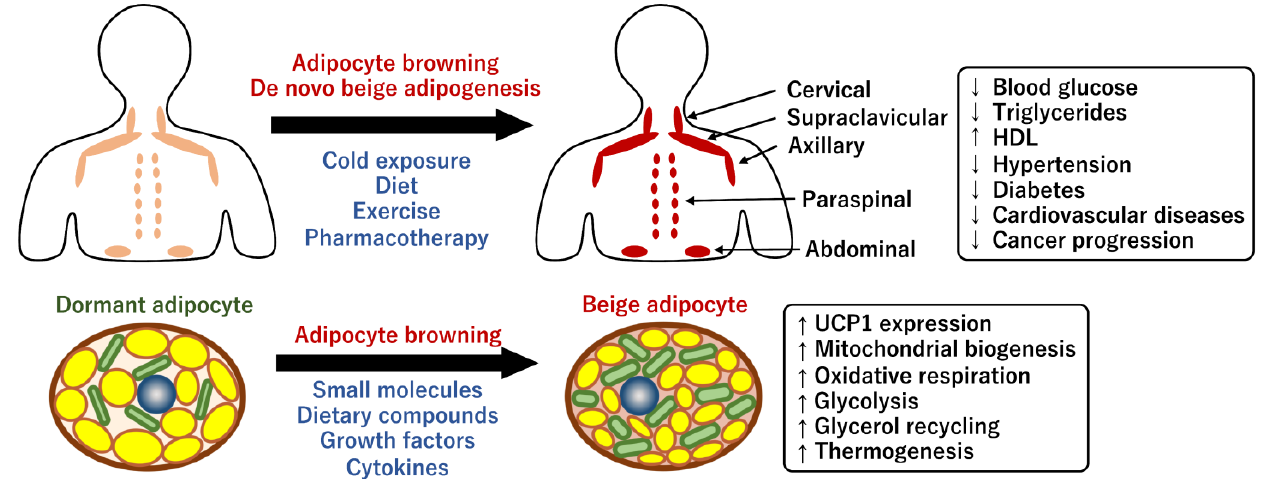
Figure 2. Anatomical distribution of human brown/beige adipocytes and their metabolic benefits. Human beige adipocytes are recruited through adipocyte browning of dormant adipocytes in specific WAT depots in response to cold exposure. The cold stimulus also likely promotes de novo beige adipogenesis from unique progenitor cells in these depots. Dietary compounds, exercise, and pharmacotherapy also contribute to these processes. Distinct metabolic benefits have been reported in individuals with detectable beige adipocytes. In in vitro cell culture systems, adipocyte browning is promoted by specific bioactive molecules including dietary compounds, growth factors, and cytokines; insights obtained from these studies could help uncover the molecular mechanisms underlying the direct regulatory action exerted by these molecules on adipocyte browning.